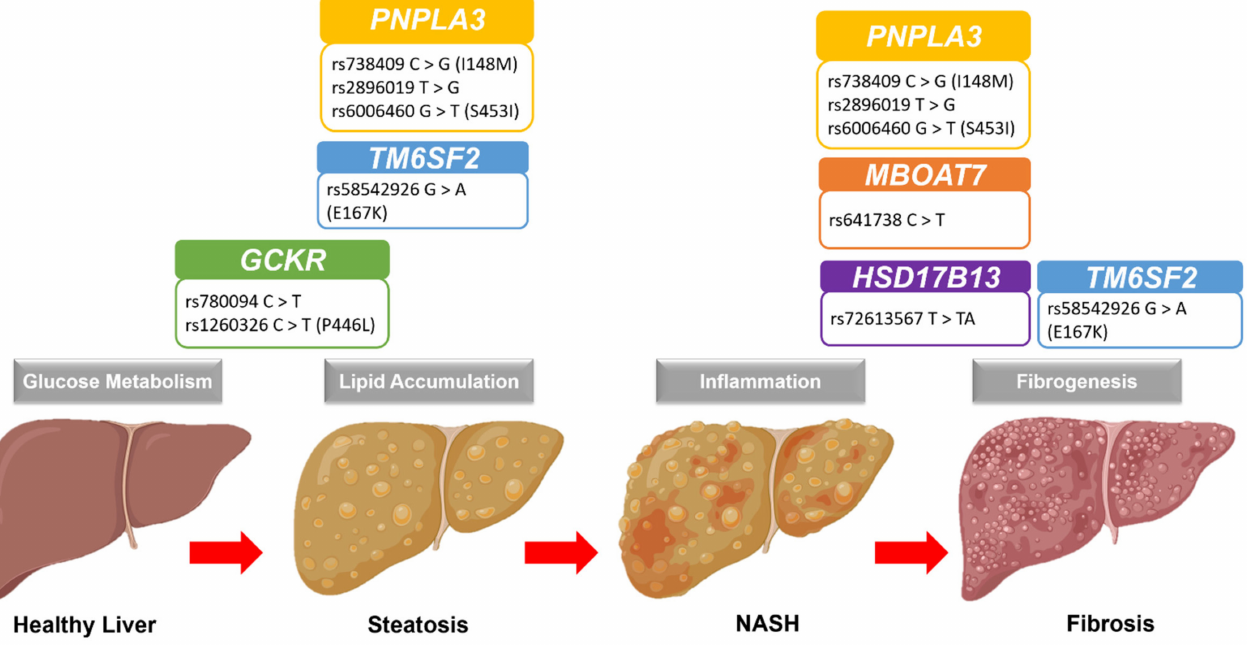
Figure 1. Graphical representation of the NAFLD progression and the most common genetic poly- morphisms. Abbreviation: GCKR: glucokinase regulatory protein; HSD17B13: hydroxysteroid 17 β -dehydrogenase; MBOAT7: membrane-bound O-acyltransferase domain-containing 7; NAFLD: nonalcoholic fatty liver disease; NASH: nonalcoholic steatohepatitis; PNPLA3: patatin-like phospho- lipase domain-containing 3; TM6SF2: transmembrane 6 superfamily member